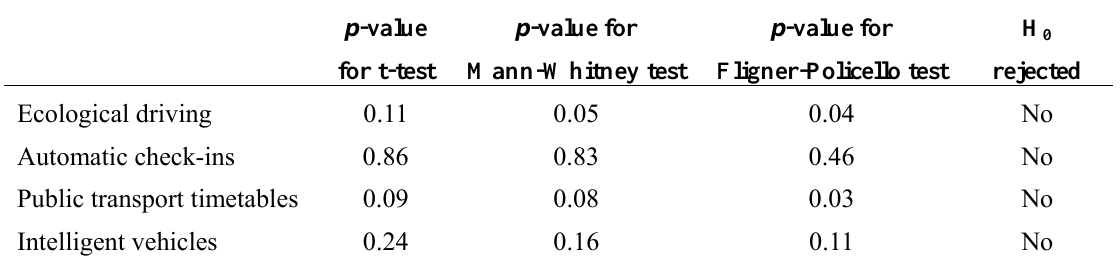
Table 8. Correlation between TUT and UPB groups regarding increased social wellbeing in the context of